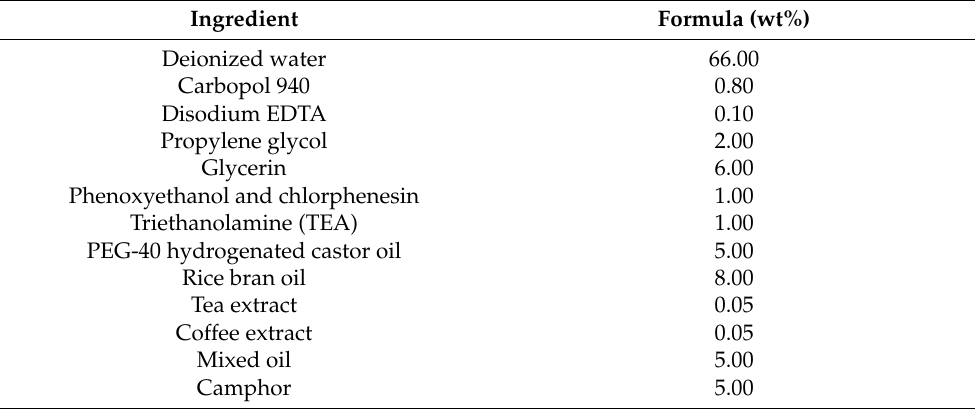
Table 1. Anti-cellulite emgel formula.